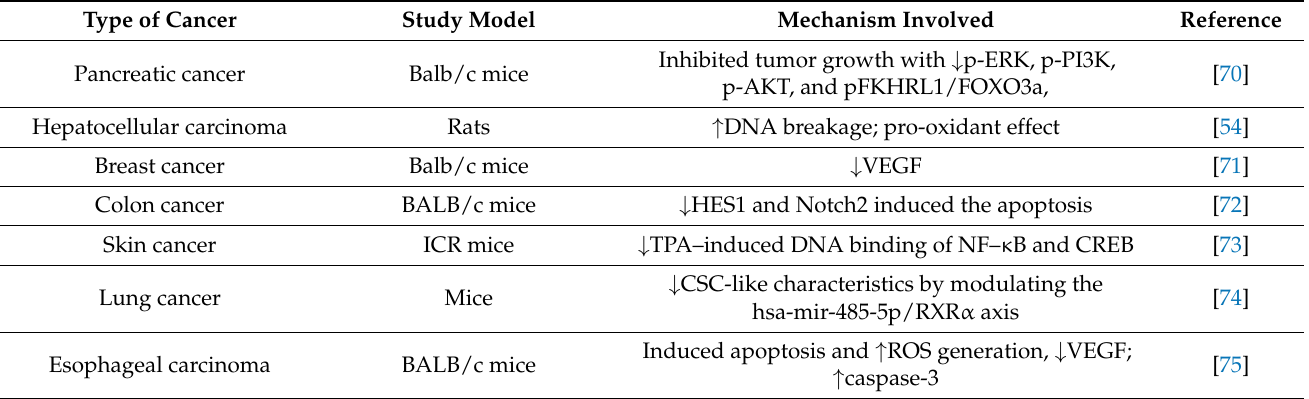
Table 3. Cancer-related molecular targets of EGCG (in vivo